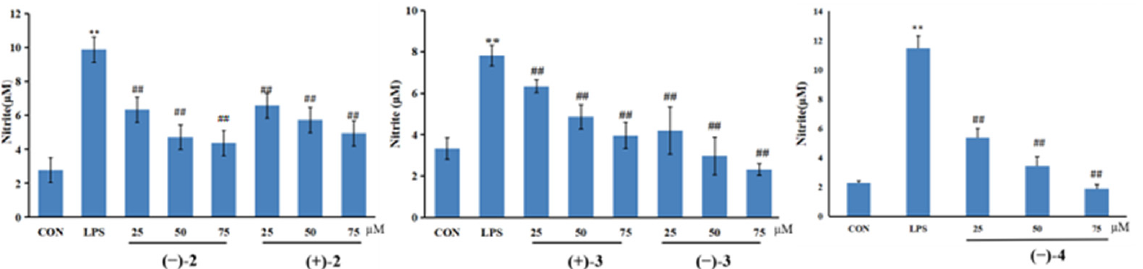
Figure 5. RAW264.7 cells were seeded in a 96-well plate and cultured with different concentrations (25, 50, and 75 µ M) of ( ± )- 2 , ( ± )- 3 , and ( − )- 4 for 1 h before stimulation with LPS (1 µ g/mL) for 24 h. The Griess reagent was used to quantify the nitrite level in the cell supernatant. Data are represented as mean ± SEM ( n = 6). ** p < 0.01 indicates statistically significant difference when compared with control group; ## p < 0.01 indicating statistical.